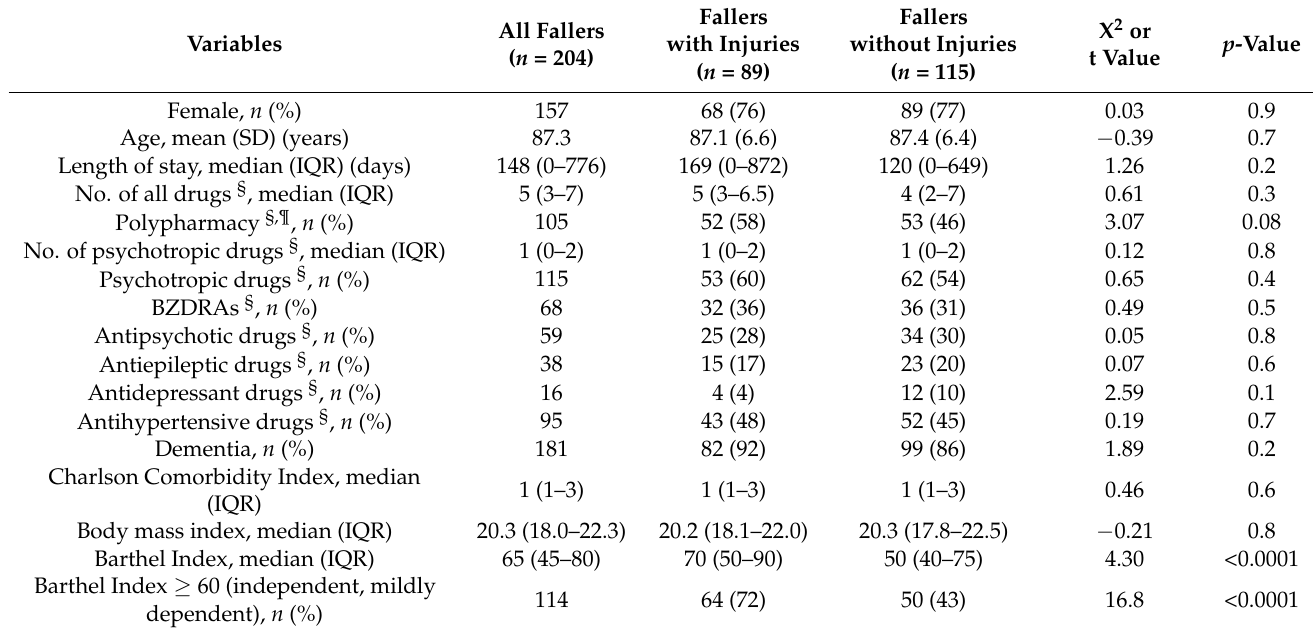
Table 4. Characteristics between fallers with and without